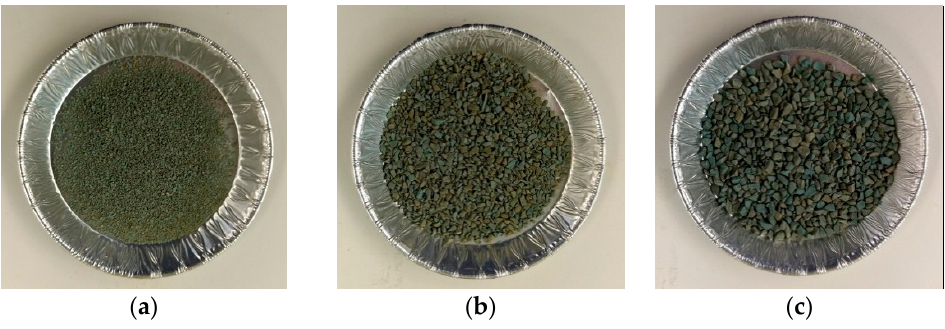
Figure 1. Images of WSRP with size range of ( a ) 0.5–1 mm (S); ( b ) 1–2 mm (M) and ( c ) 2–4 mm (L).